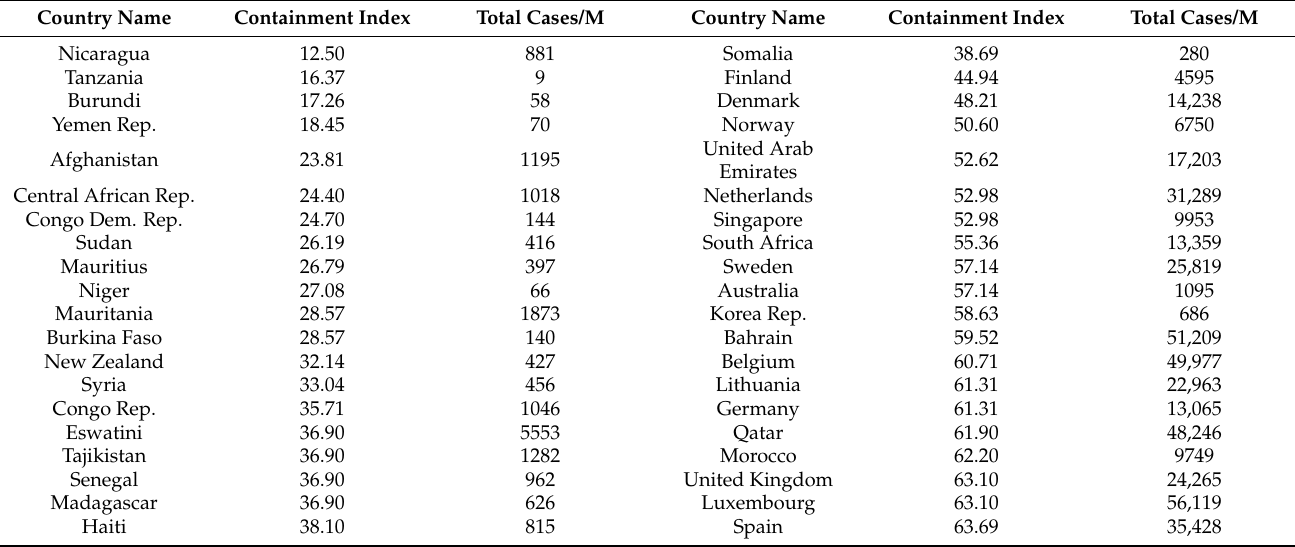
Table 1. Countries ranked by containment